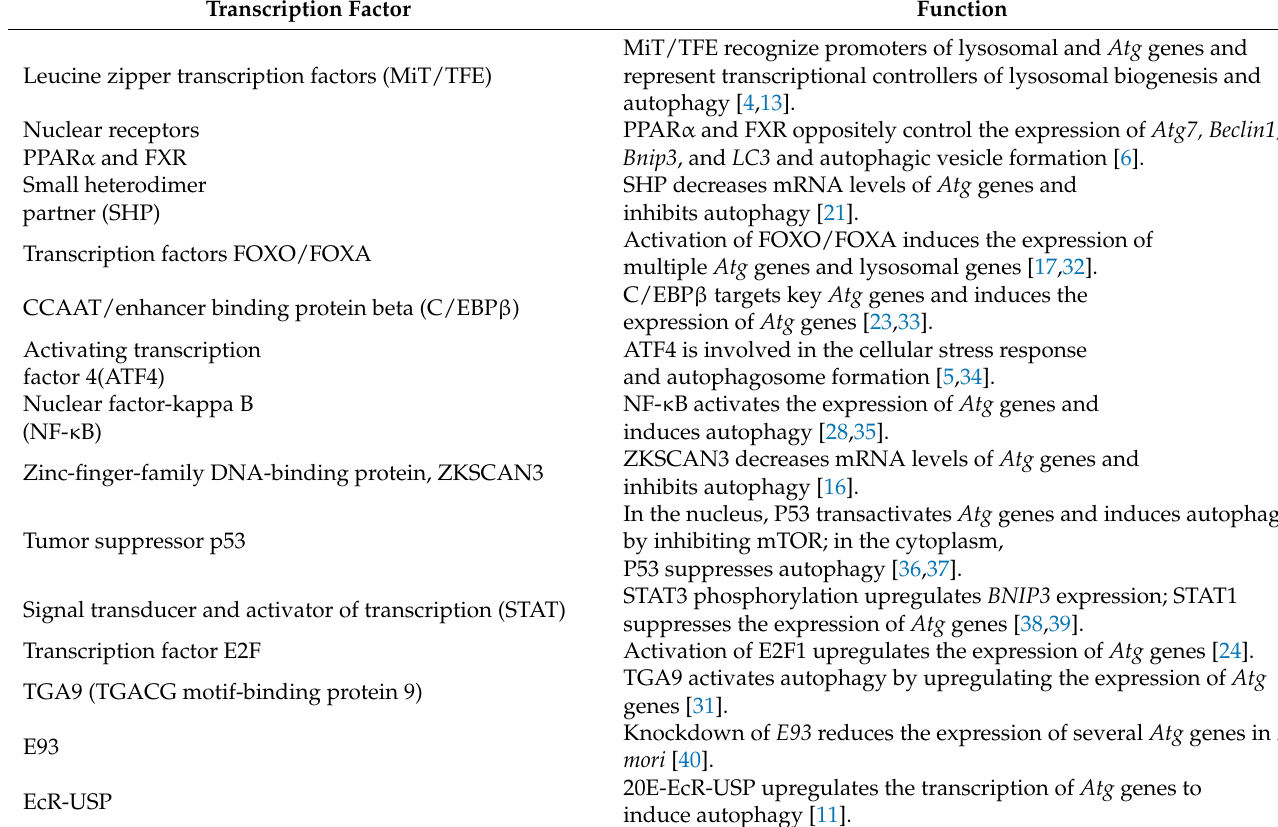
Table 1. Transcription factors and their function in